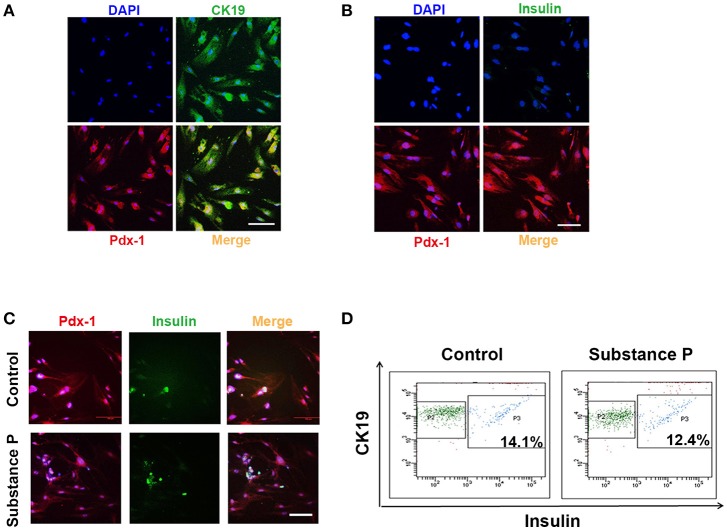
Substance P did not promote differentiation of adult pancreatic ductal cells into Beta-Cells. P3 ductal cells were treated with substance P (10−6, 10−2, and 10−1 μM) for 28 days. Immunostaining was performed to identified the differentiation of ductal cells. (A) Cells were Pdx-1 (red) and CK19 (green) positive. Scale bar: 100 μm. (B) Cells were Pdx-1 (red) positive but insulin (green) negative. Scale bar: 100 μm. (C) After 28 incubation of induction medium (DMEM/F12 plus 2% FBS, 10 mmol/L Niacinamide, 20 ng/ml HGF, 20 μg/L bFGF, and 10 nmol/L exendin-4) with or without substance P (10−6, 10−2 and 10−1 μM) for 28 days, ductal cells were immunostained by Pdx-1 (red) and insulin (green) antibodies. A portion of Pdx-1 positive cells expressed insulin. Scale bar: 100 μm. (D) Flow cytometric analysis of CK19 and insulin expression on pancreatic ductal cells. Data was compared with isotype-matched controls. One representative experiment of three is shown.